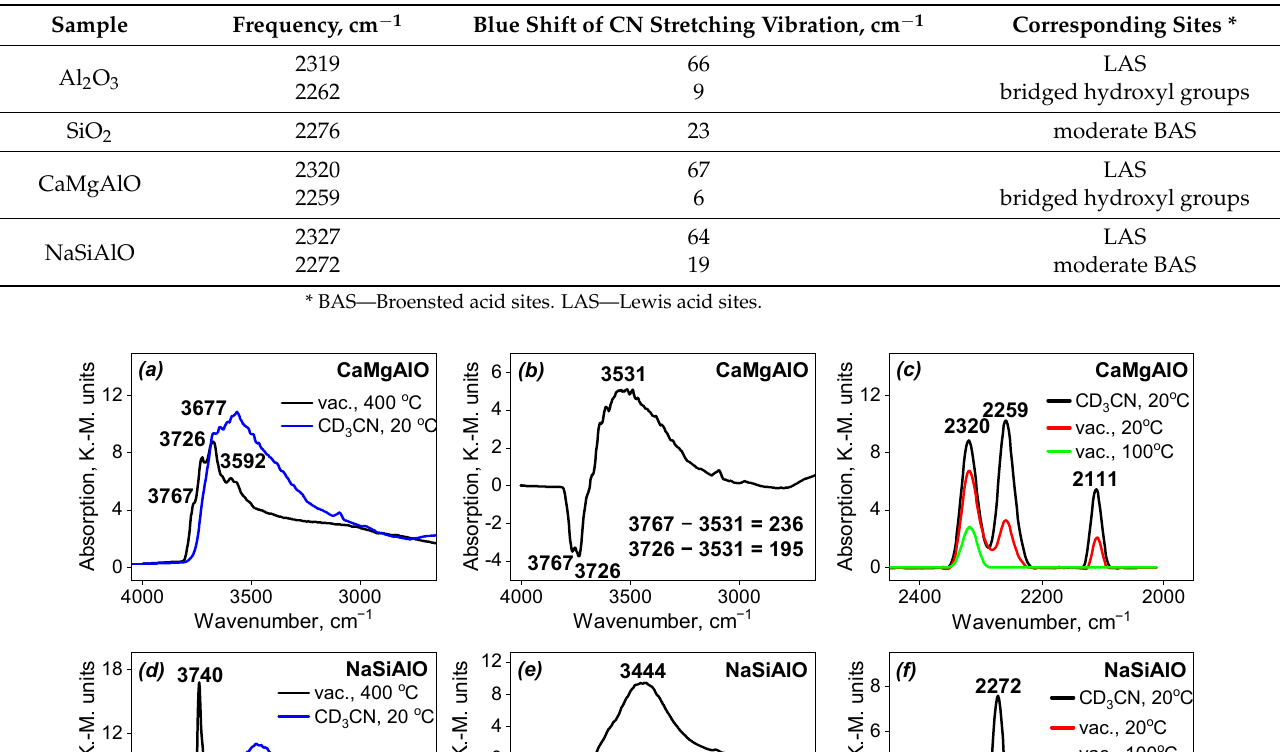
Table 3. The shifts of stretching vibrations of CN groups upon interaction with CD 3 CN (strong base) and the blue shift of stretching ν C ≡ N vibrations compared to the gas phase frequency (2253 cm − 1 ) [35,37,47,48].